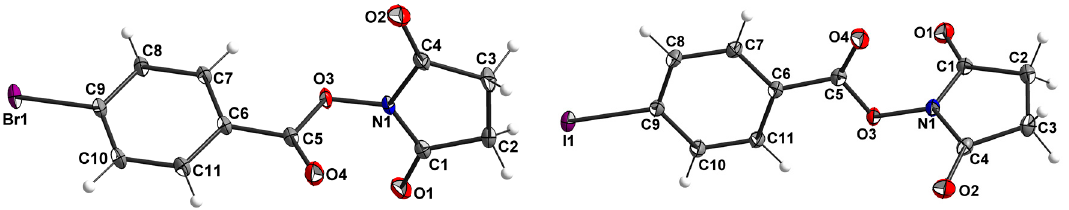
Figure 2. A view of the molecular structures of 3c ( left ) and 3d ( right ), showing the atom labeling scheme. Displacement ellipsoids are drawn at the 50% probability level.